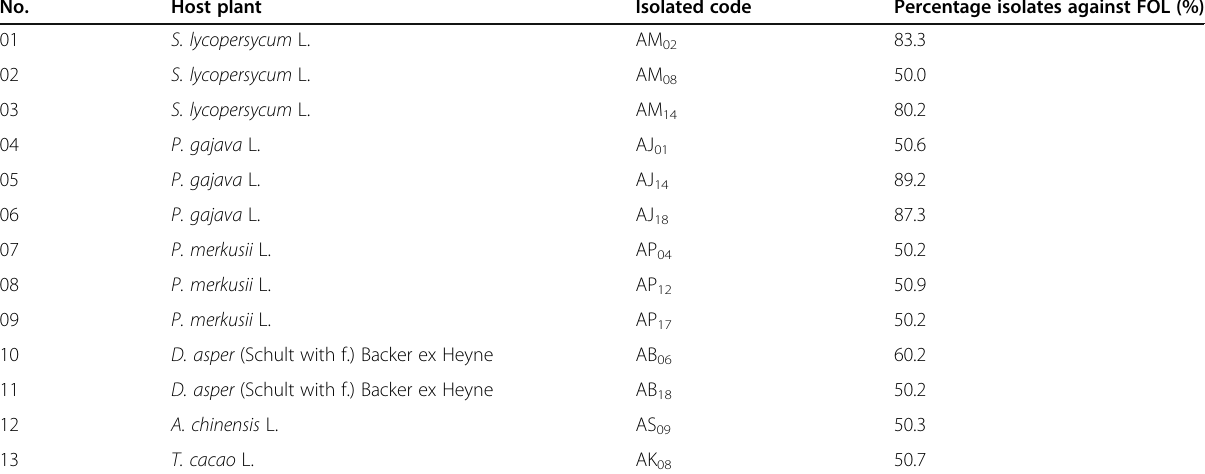
Table 1 Percentage of antagonistic activity of 13 endophytic bacteria in suppressing Fusarium oxysporum f. sp. lycopersici (FOL) No.